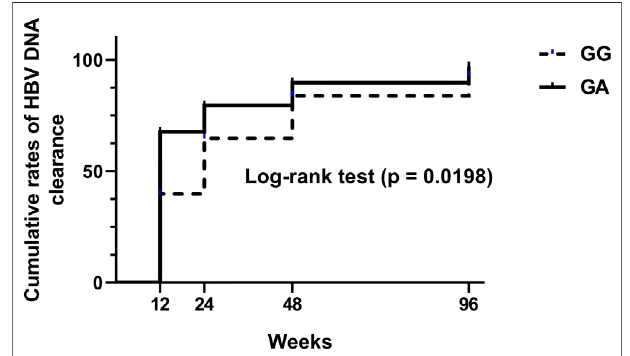
FIGURE 4 | A Kaplan-Meier curve was plotted to assess the cumulative rate of HBV clearance ( < 20 IU/ml) at each time point, and the difference between the groups was assessed by a log-rank